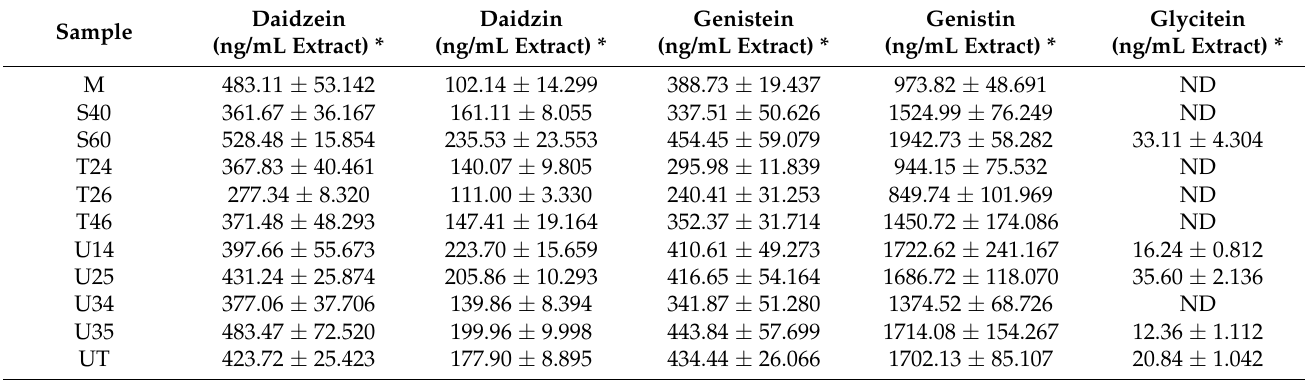
Table 6. Isoflavonoid compounds in the selected